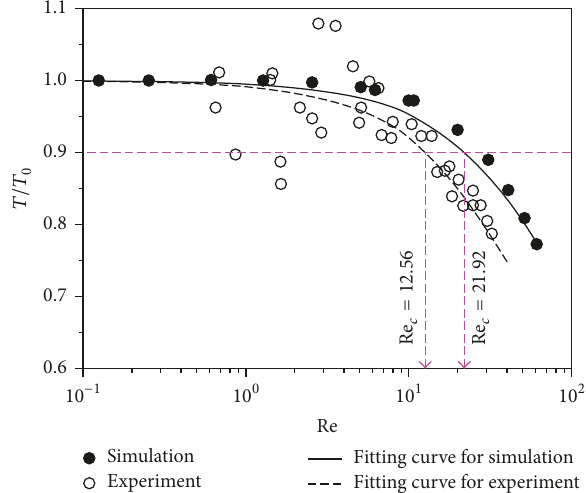
Figure 7: Relationships between 𝑇/𝑇 0 and Re based on the data replotted from Zimmerman et al. ([88], Figure 2 ).